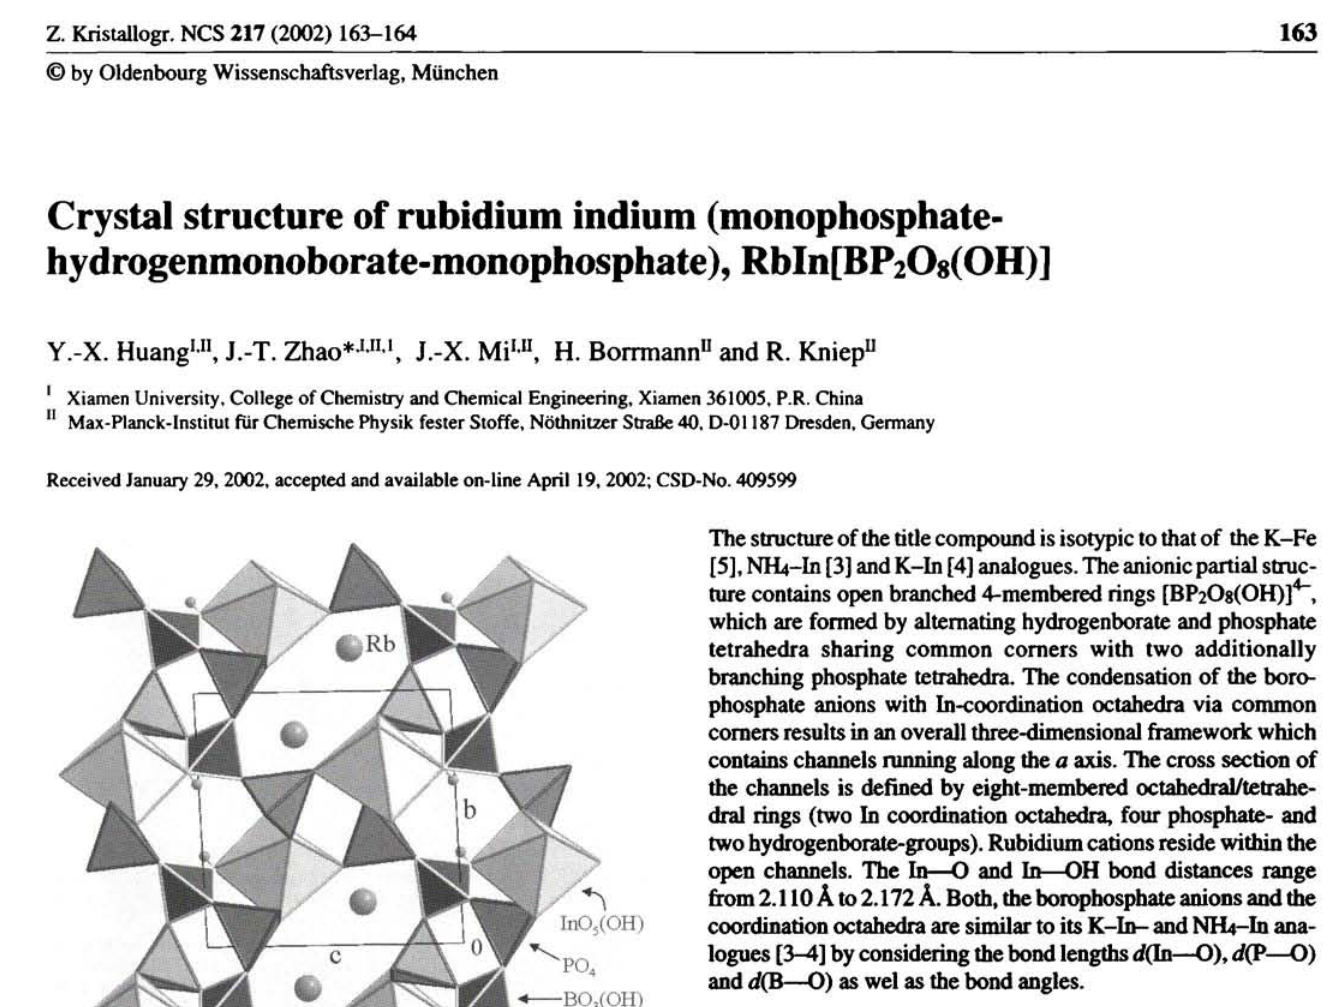
Table 1. Data collection and handling.